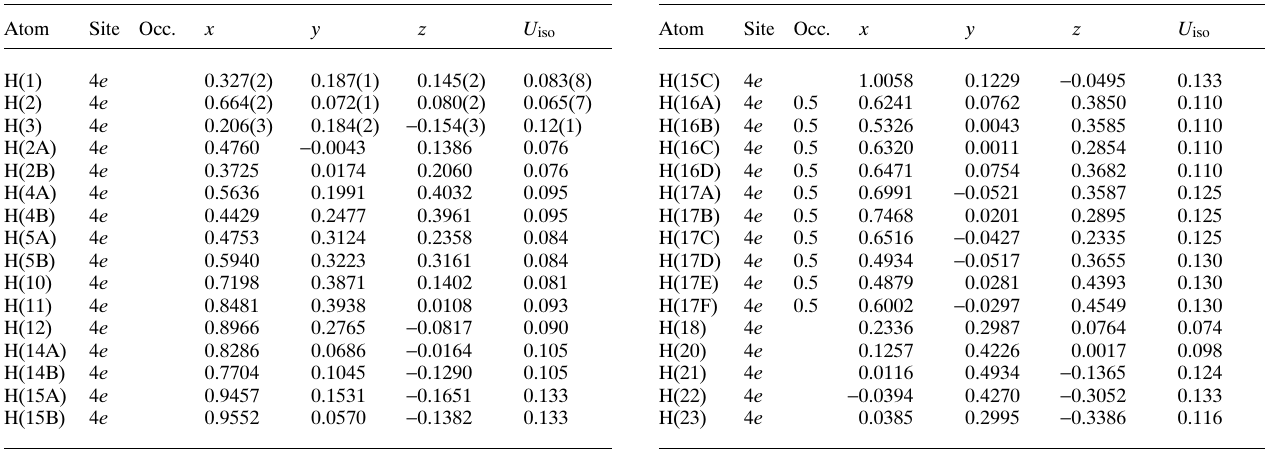
Table 2. Atomic coordinates and displacement parameters (in Å 2 )